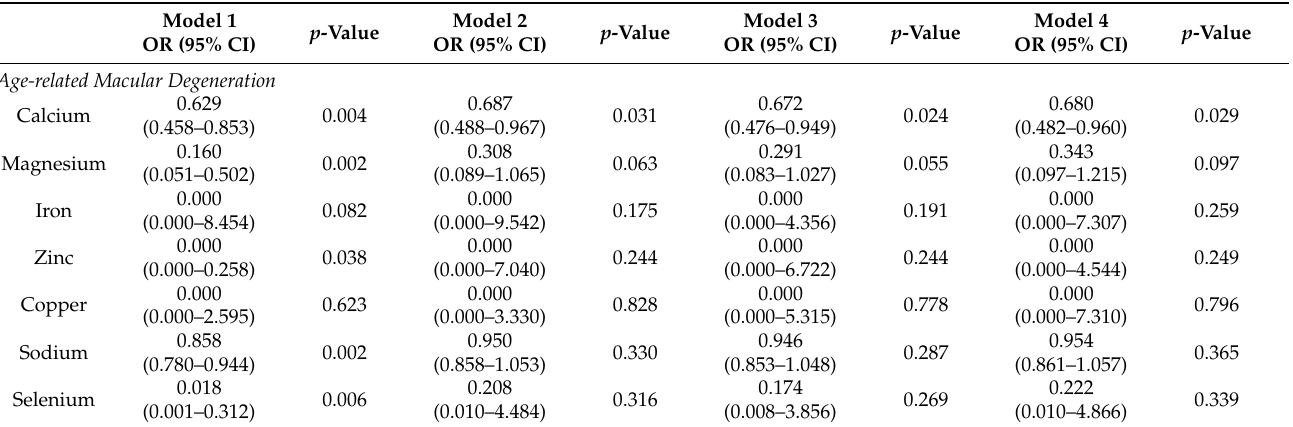
Table 2. Association between dietary micronutrients and the presence of age-related macular